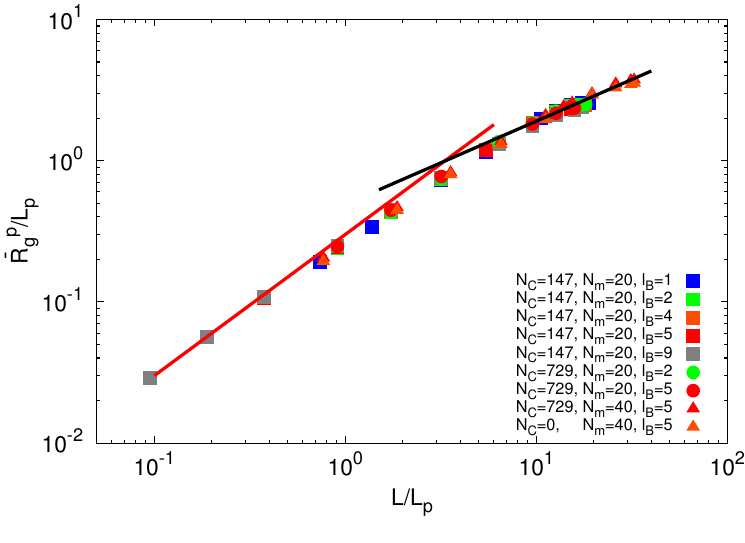
/l = 1 , 2 , 5 and 9 . The black line is proportional to ( L/L B p